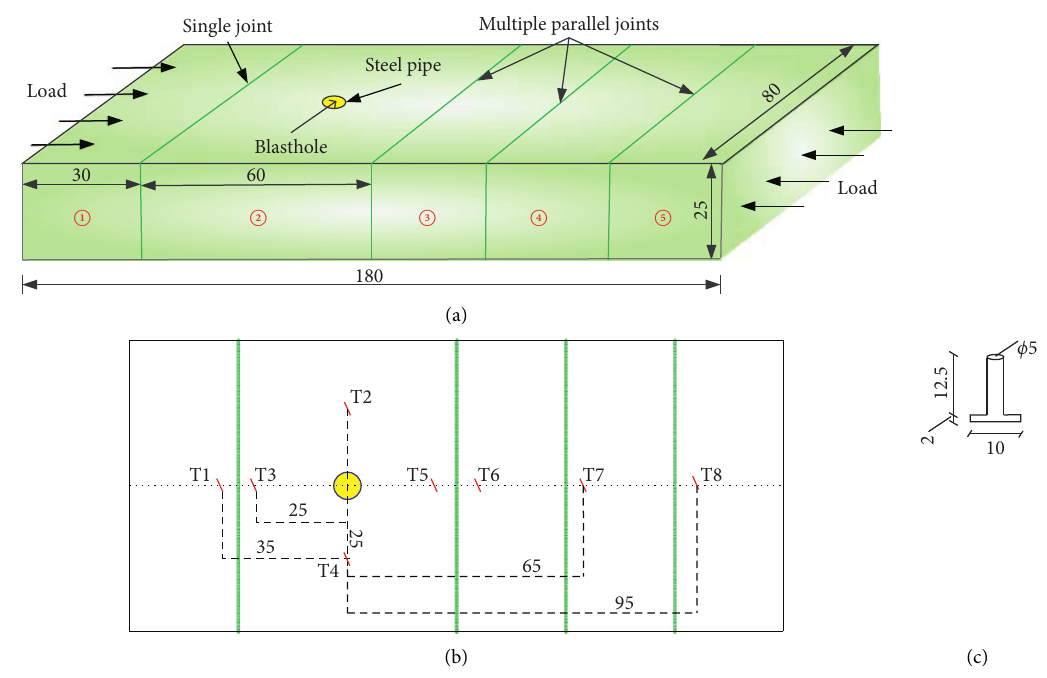
Figure 1: Schematic diagram of the model for stress waves propagating across jointed rock masses under unidirectional in situ stress (unit: